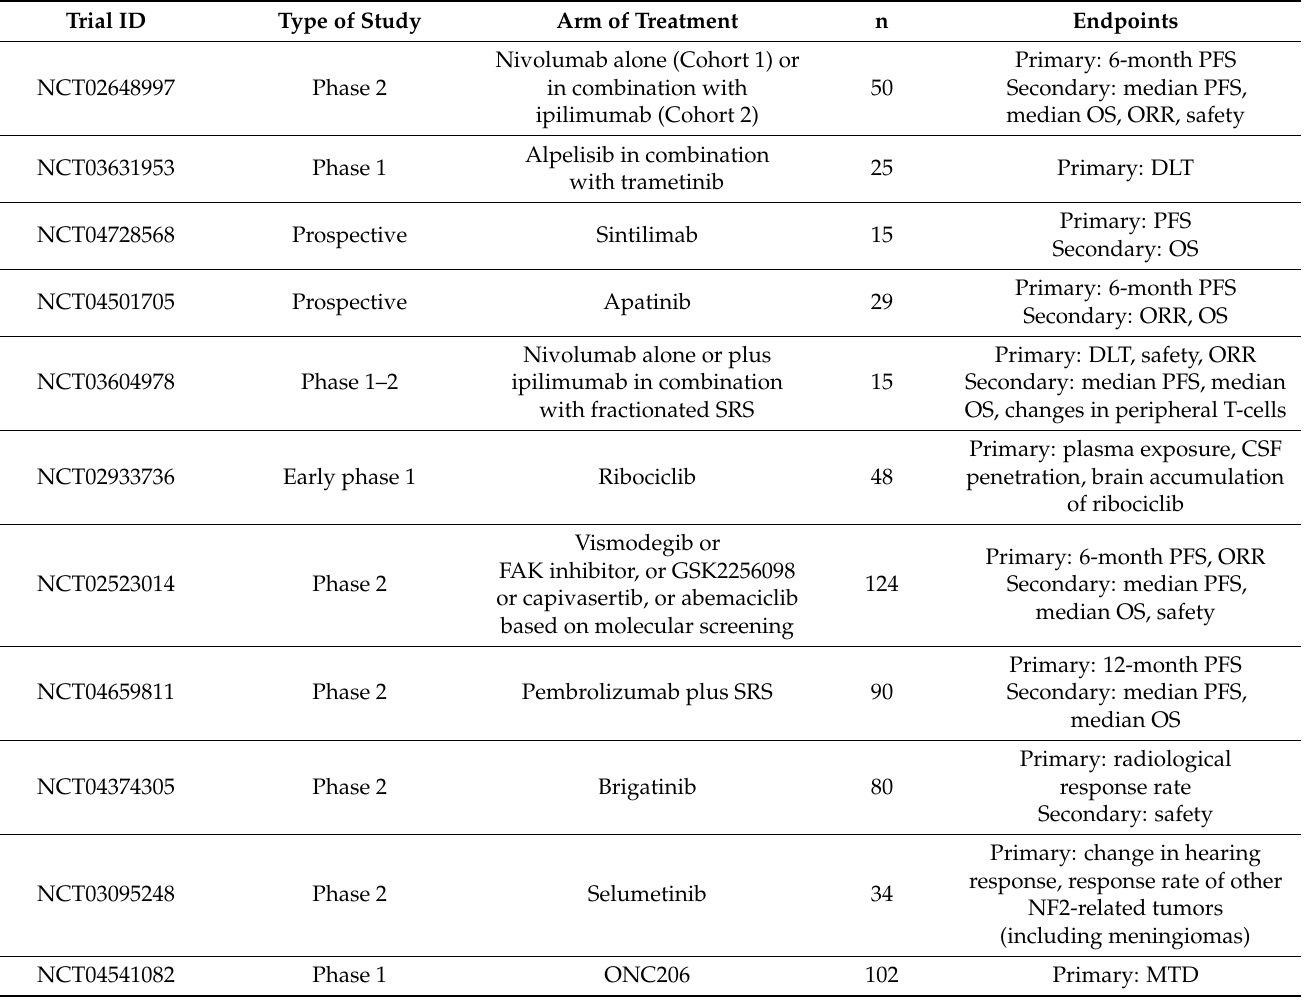
Table 3. Ongoing clinical trials on systemic treatments in